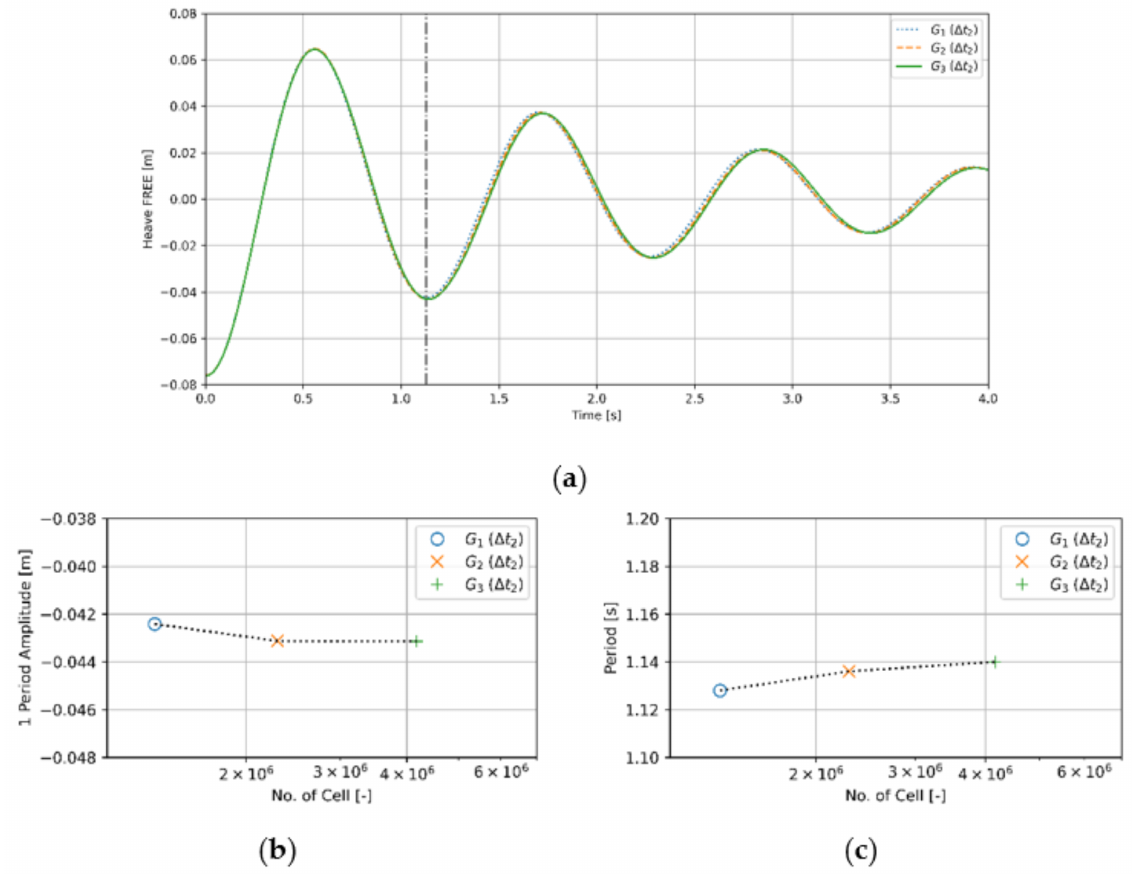
Figure 8. Time histories freely decaying heave motions: ( a ) the associated amplitude; ( b ) period; ( c ) of the first oscillation period obtained on grids G 1 , G 2 , and G 3 for the grid